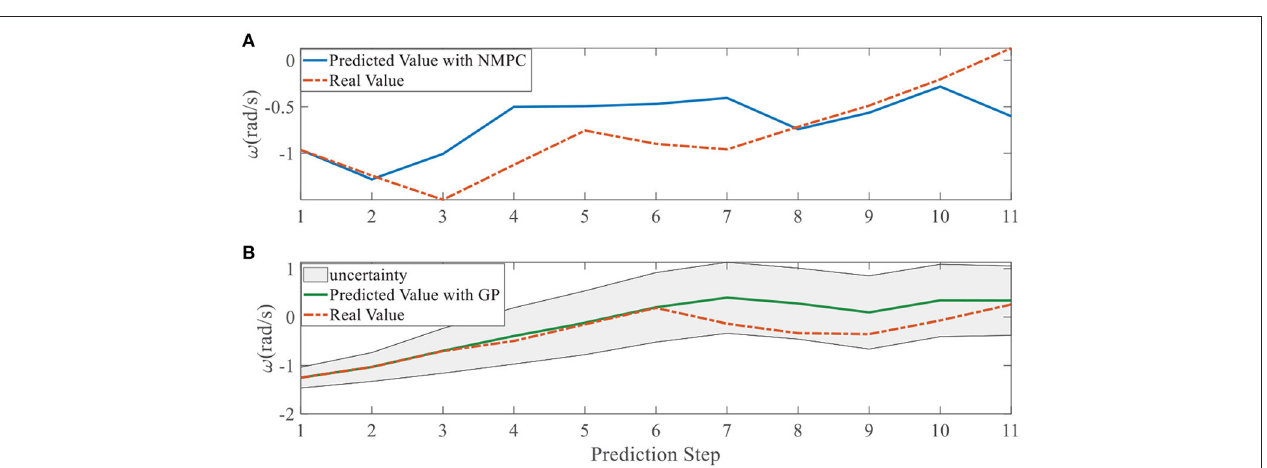
FIGURE 18 | Yaw rate evolution in right overtaking. (A) NMPC; (B) GPMPC.